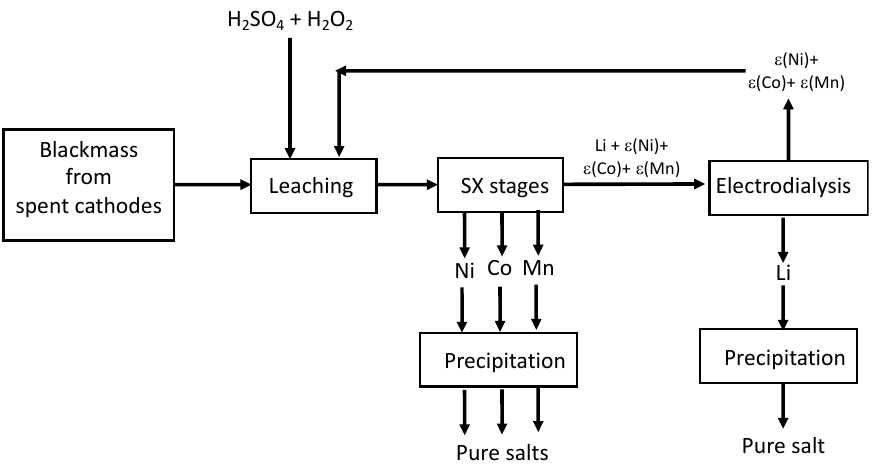
Figure 6. General concept of the implementation of ED unit operation in hydrometallurgical processes for the production of high-grade lithium salts.